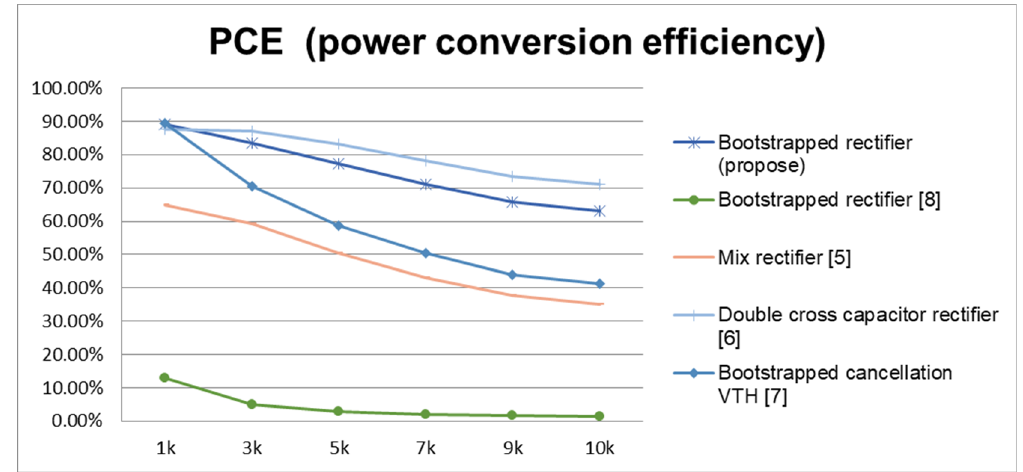
Figure 19. Adjusting the VCE RL for various rectifiers.